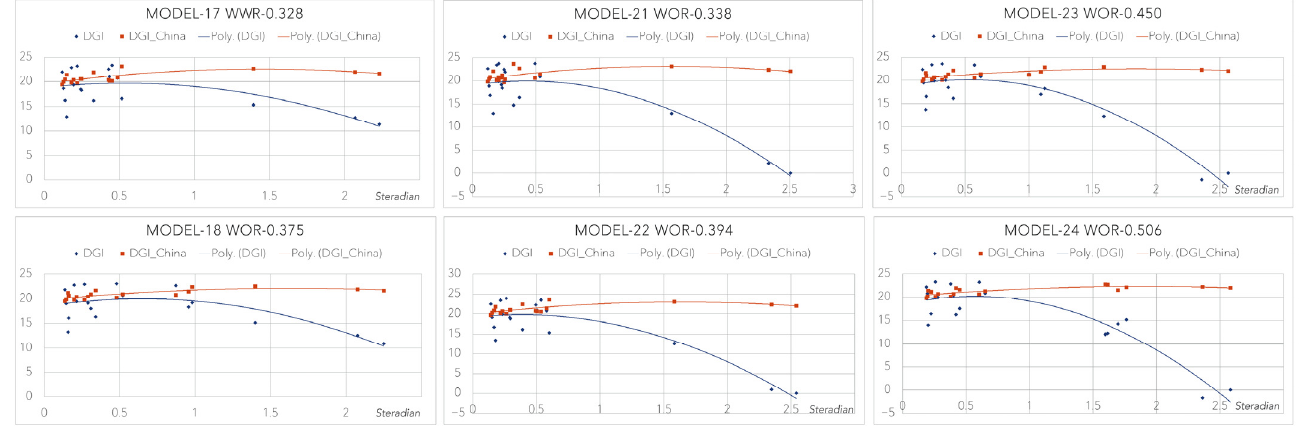
Figure 12. Comparative study on window sizes (WWR > 0.3) with solid angles ( X -axis) against DGI and DGI China evaluation ( Y -axis).